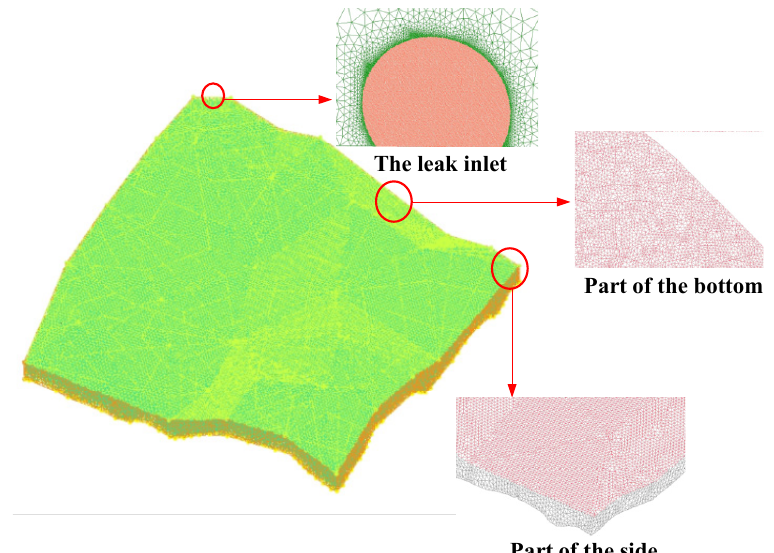
Figure 2. Grid details.